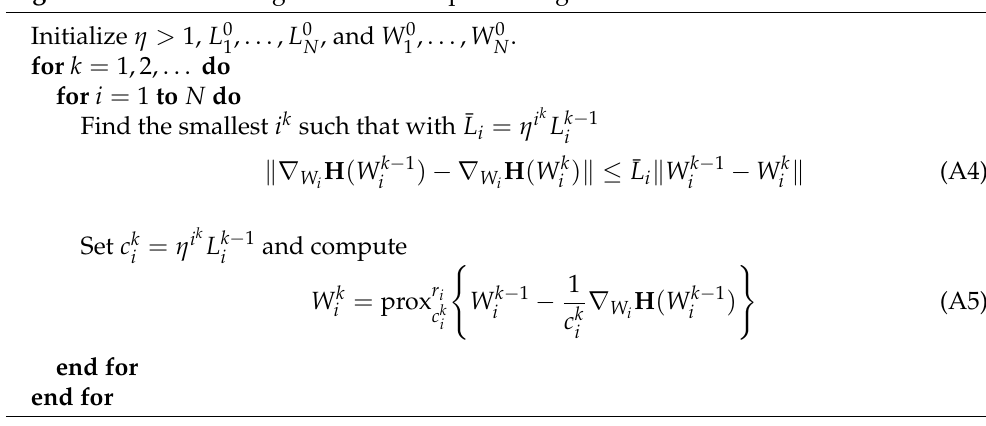
Algorithm A1 PALM Algorithm for Deep Learning